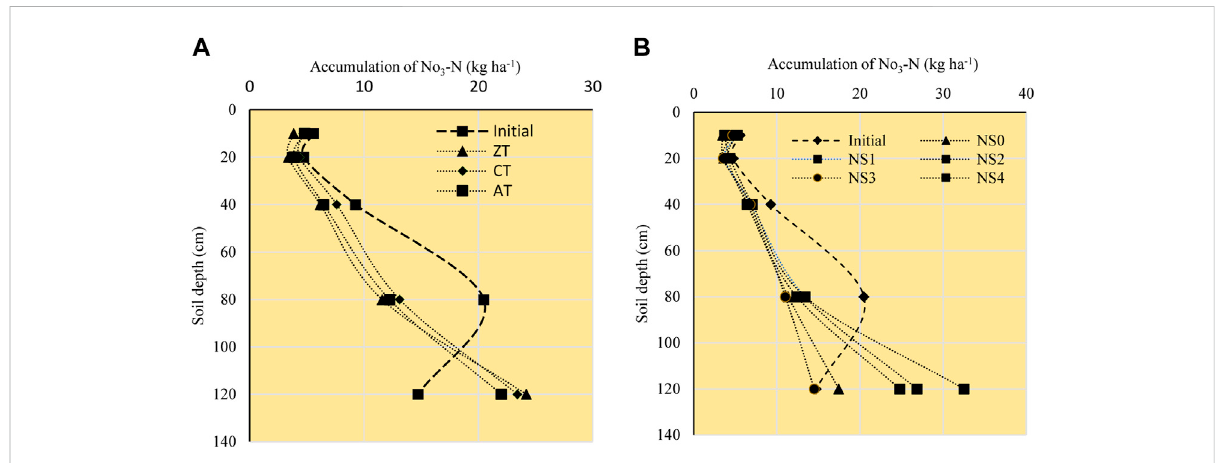
FIGURE 4 Effect of tillage (A) and N sources (B) on accumulation of nitrate nitrogen (kg · ha − 1 ) in different soil depths at the end of experiment. ZT, zero tillage; CT, conventional tillage; AT, alternate tillage (maize: zero and rice: conventional tillage), NS 0 = no nitrogen (control, 0:50:100), NS 1 = recommendeddoseofNPKfertilizer(N 160 P 50 K 100 ),NS 2 =NS 1 +cropresidueat6 Mg/ha,NS 3 =75%ofrecommendedNasfertilizeralongwith25%N asFYM (N 120 P 50 K 100 + FYMat40 kg · N/ha), NS 4 =75% ofrecommendedN asfertilizer along withat25%Nasvermicompost(N 120 P 50 K 100 +VM at 40 kg ·